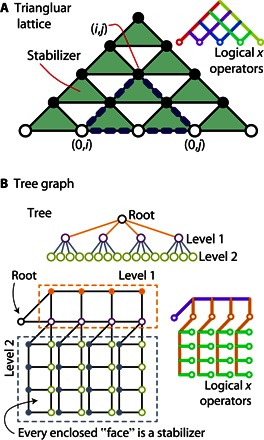
Lattice variants.(A) The lattice for encoding all-to-all connected logical spins using three-spin stabilizers. Here, the number of physical spins is NP = 15 and the number of logical spins is N = 5. The number of stabilizers must then be NS = NP − N = 10, and we choose these to be triangular stabilizers (green triangles). Each circle denotes a physical spin. Empty circles are vertex spins (0, j), and solid circles are edge spins (i ≠ 0,
j). Spins (0,
i), (0,
j), and (i, j) always form an isosceles triangle (marked with the dashed blue line). (B) Stabilizer code of the tree graph logical model. The top figure depicts the logical model, the bottom left figure depicts the physical lattice used to encode the logical model, and the bottom right figure depicts the chains of logical x operators. Each empty circle denotes a vertex physical spin (or a logical spin in the tree graph), and each solid circle denotes an edge spin corresponding to the two-body Ising interaction between two logical spins. Each plaquette corresponds to a stabilizer, as in Fig. 1A.